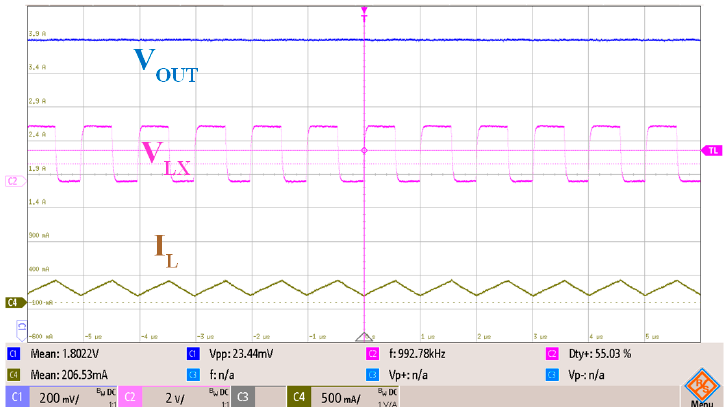
Figure 10. Measured light load steady-state response of the proposed DC-DC buck converter ( V OUT = 1.8 V; I LOAD = 200 mA).